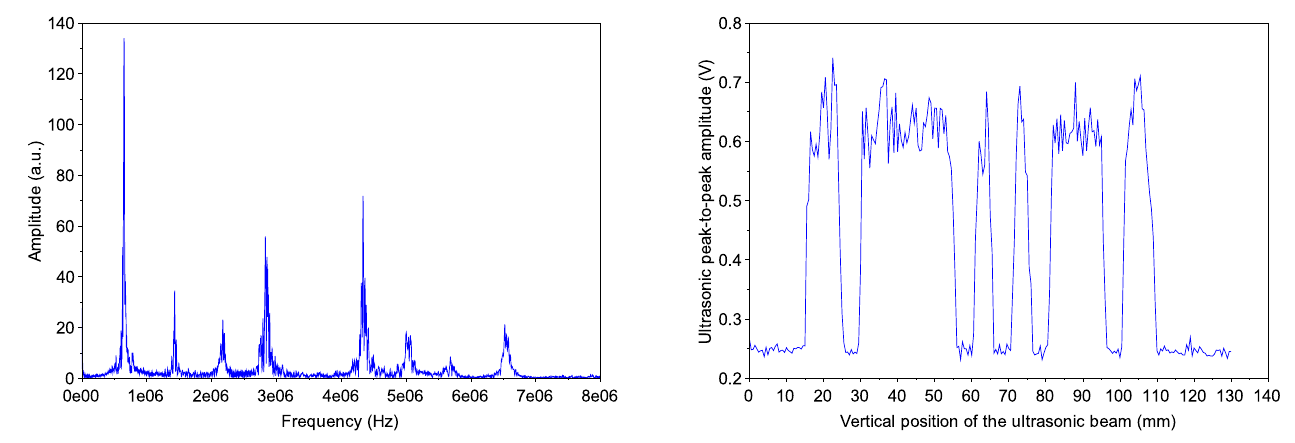
Fig. 4. Fourier transform of the echo reflected by the mock-up (in absence of notch).